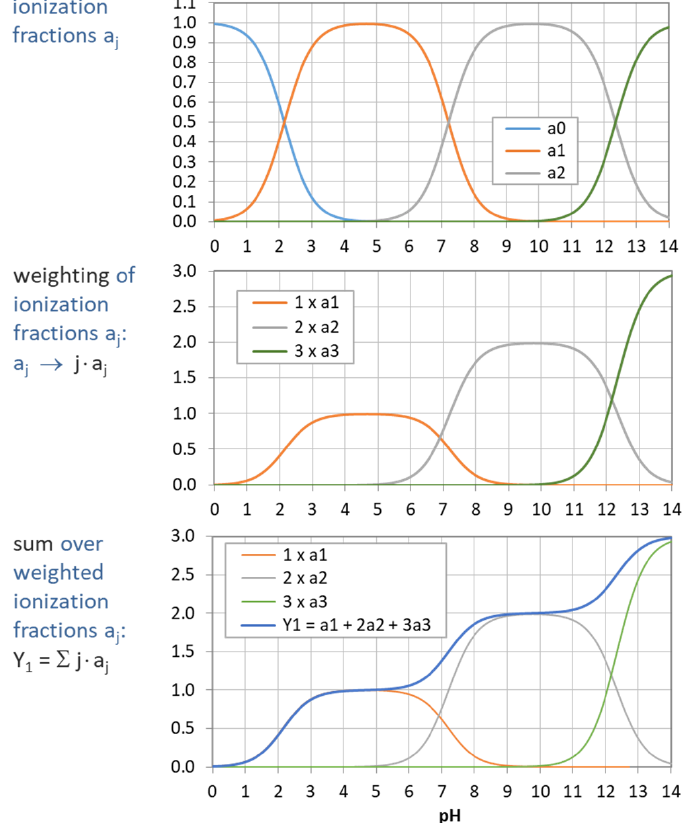
Figure 5. Construction of Y 1 (blue curve in bottom diagram) from summation over weighted ioni- zation fraction a j . (Example: phosphoric acid as a triprotic acid.)